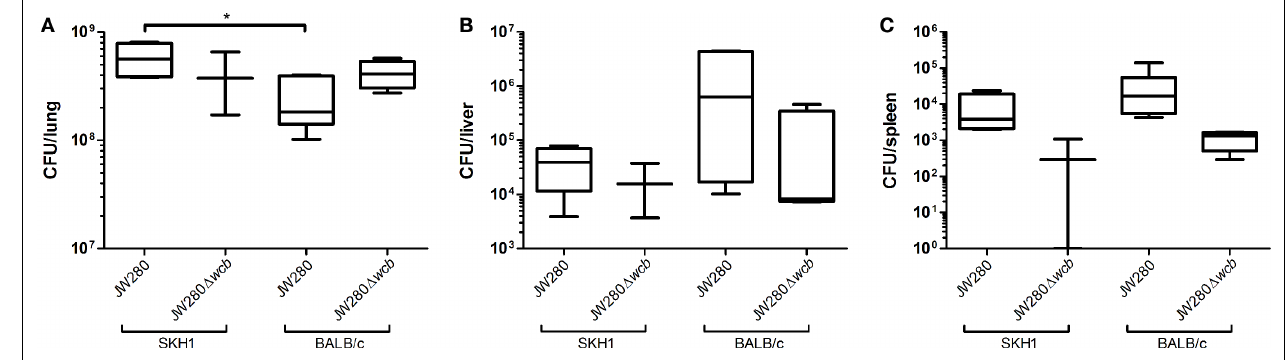
FIGURE 5 | B. pseudomallei colonization of key sites of infection. SKH1 and BALB/c mice infected i.n. with JW280 (10 4 CFU) or JW280 (cid:2) wcb (10 6 CFU) were euthanized at the onset of morbid disease symptoms, organs were harvested, homogenized in PBS and bacteria were enumerated. Data indicates the total number of bacteria detected per organ for lung (A) , liver (B) , and spleen (C) . Significant difference between data sets indicated by asterisk (* p < 0.05).